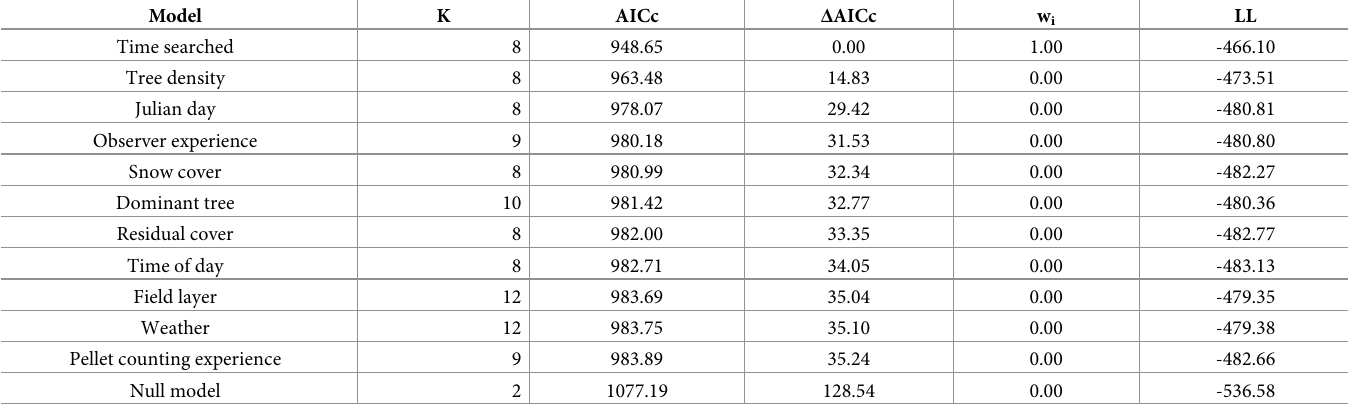
Table 2. Model selection table from multinomial Poisson mixture models. Covariates listed here were used only on detection probability (p). For all models, cutting class was the sole covariate used on abundance and is not listed in the table. Model